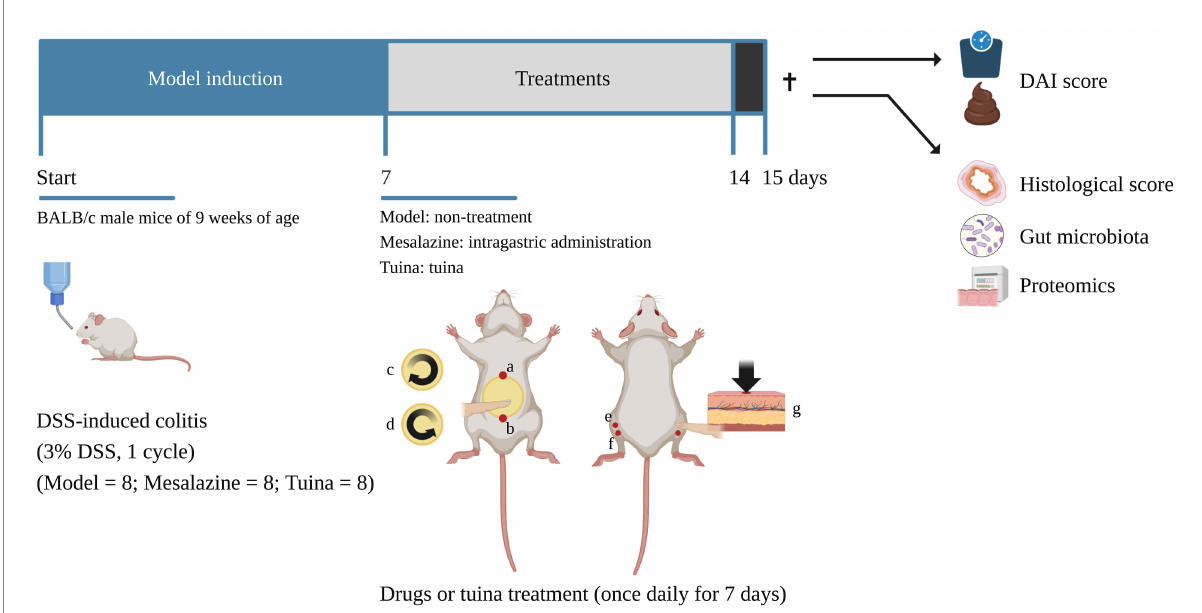
FIGURE 1 Timeline of the experiment. , time point of sacrifice, the arrow above indicates before the sacrifice and the arrow below indicates after the ✝ sacrifice. a and b form the abdomen operation area. a, RN 15; b, RN 4. c and d indicate the direction of the rubbing manipulation. (c), clockwise for 3 min; (d), counterclockwise for 3 min. (e), ST 36 (bilateral); (f), ST 37 (bilateral). g indicates the direction of the pointing manipulation [images with permission created with BioRender. https://biorender.com (2022)].